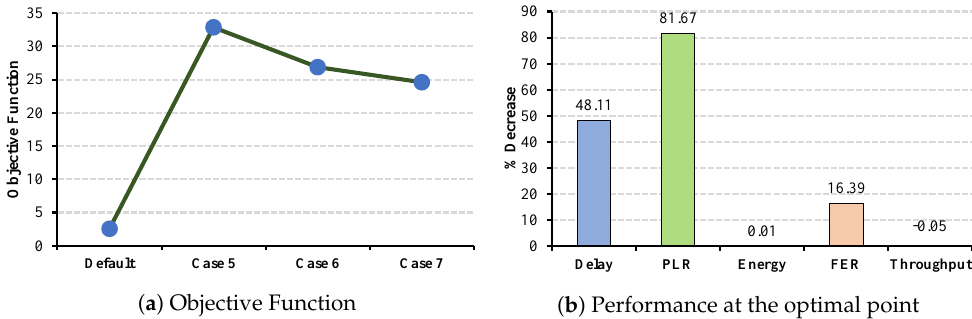
( b ) Performance at the optimal point Figure 18. EEG QoS metrics and energy consumption under CW changes for master